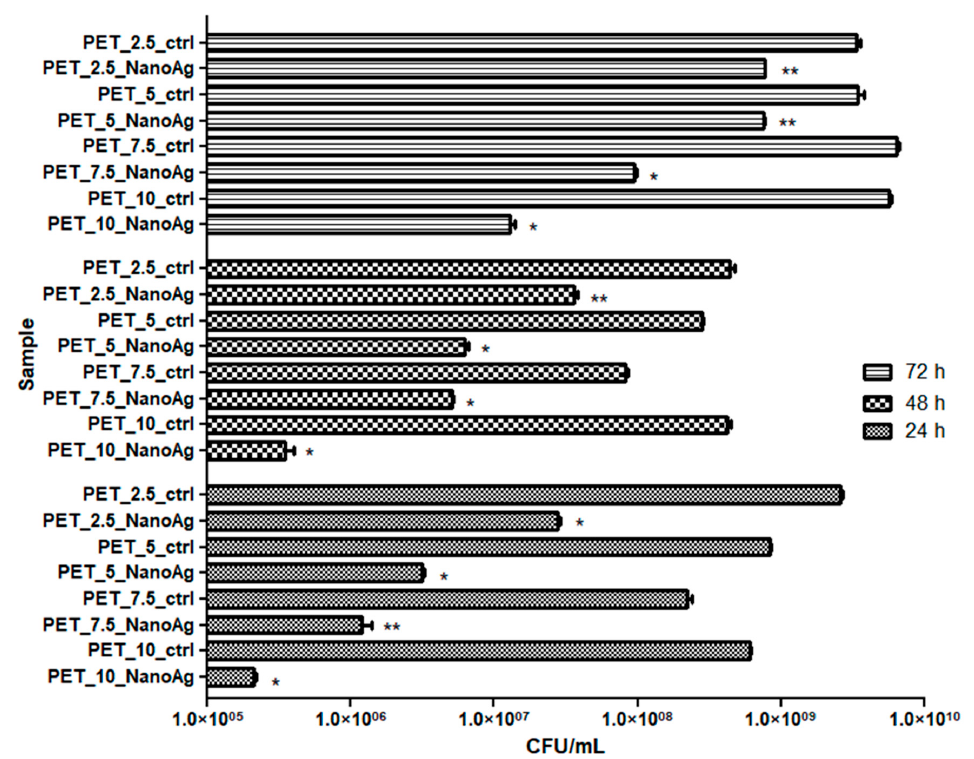
Figure 8. Graphic representation of colony-forming units (CFU)/mL representing the number of S. aureus viable cells included in the monospecific biofilms developed on the surface of the materials, quantified after 24 h, 48 h, and 72 h at 37 °C. * p ≤ 0.001, ** p ≤ 0.05 comparing control PET and NanoAg PET obtained at the same flow rate.